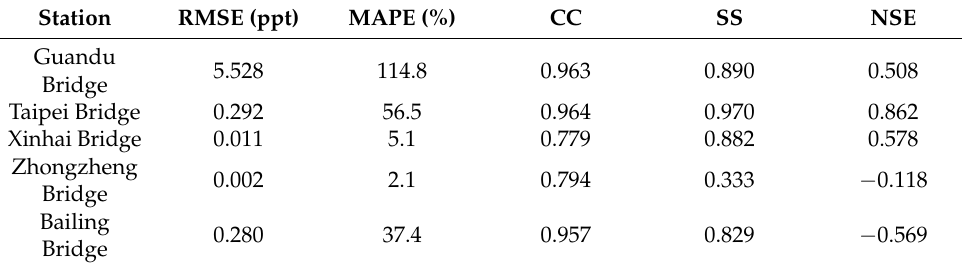
Table 5. Statistical errors between the simulated and measured